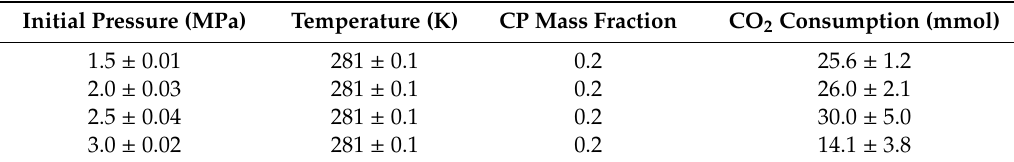
Table 1. Total CO 2 consumption in hydrate formation with di ff erent initial pressure.